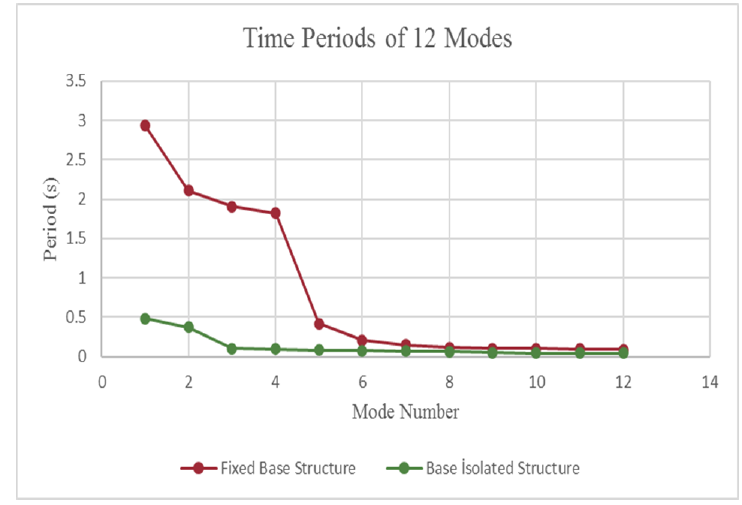
Figure 7. The periods and modes of the historical mosque.